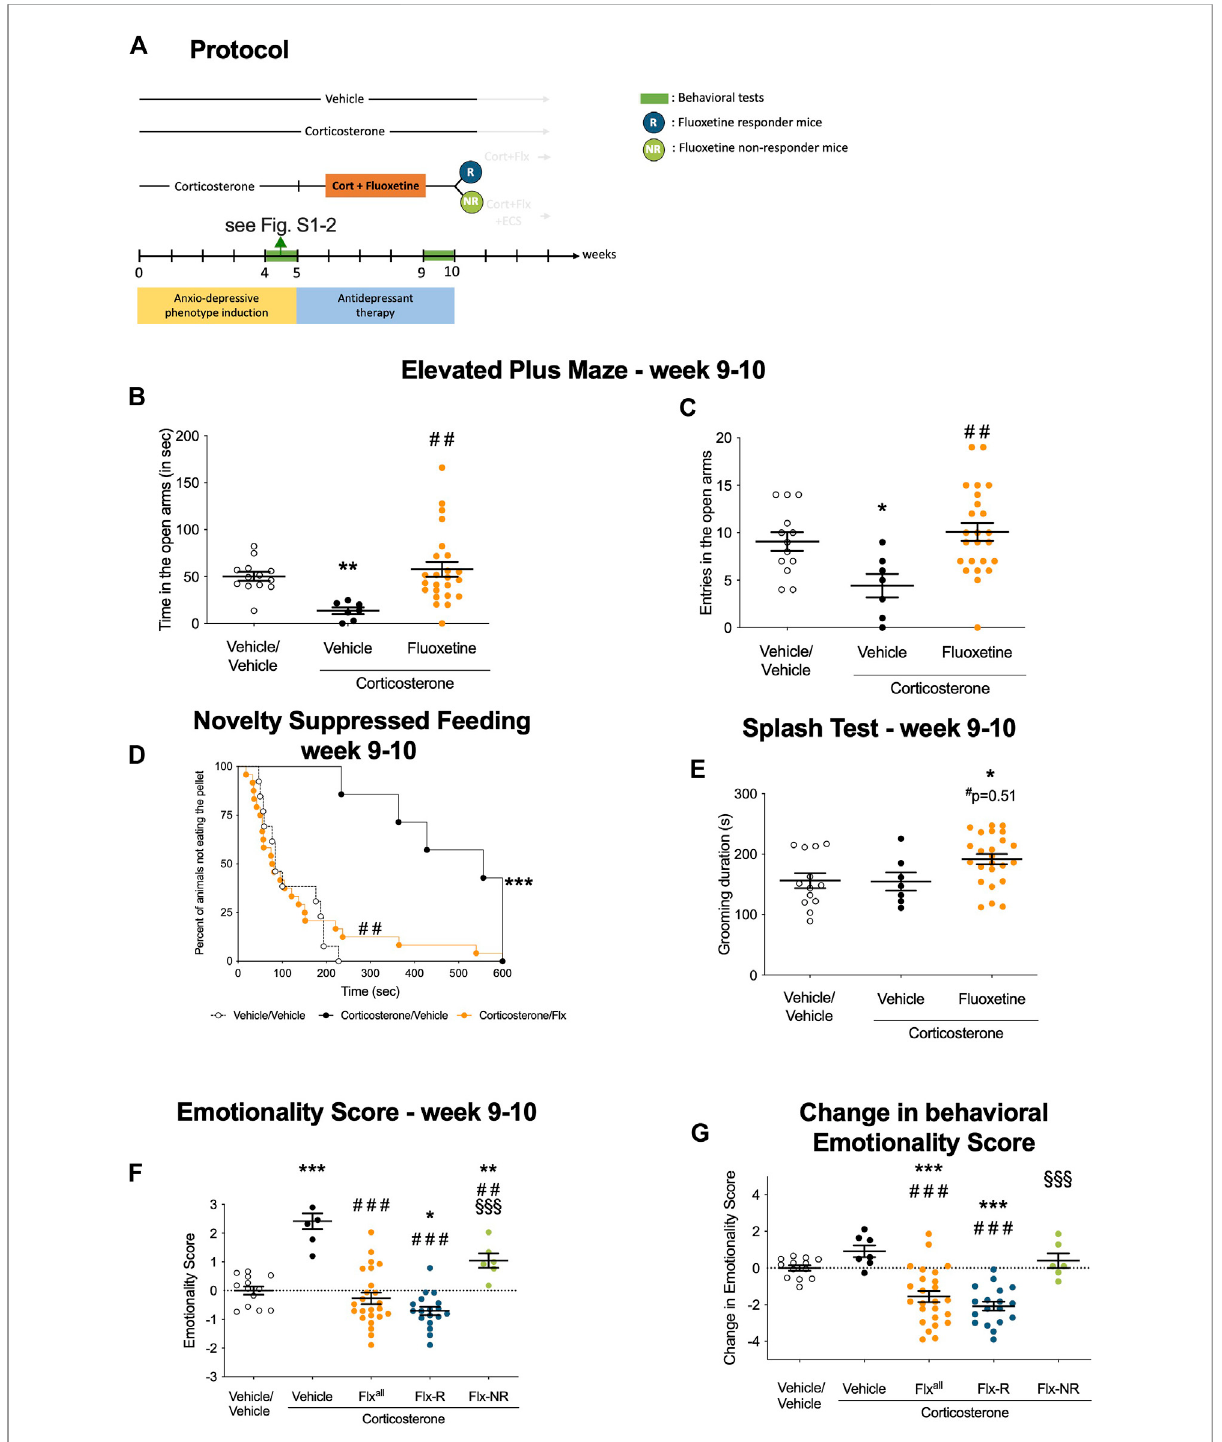
FIGURE 1 Chronic fl uoxetine treatment produces reversed anxiety and depression-like phenotype in a mouse model of anxiety/depression. (A) Timeline of experiments: In place of normal drinking water, grouped-housed male C57BL/6JRj mice were presented during 10 weeks with vehicle (0.45% hydroxypropyl- β -cyclodextrin) or corticosterone (35 μ g/ml) in the presence or absence of an antidepressant ( fl uoxetine, 18 mg/kg/day) during the last 5 weeks of the corticosterone regimen. Emotionality z-score was calculated after each behavioral session. Then, we investigated